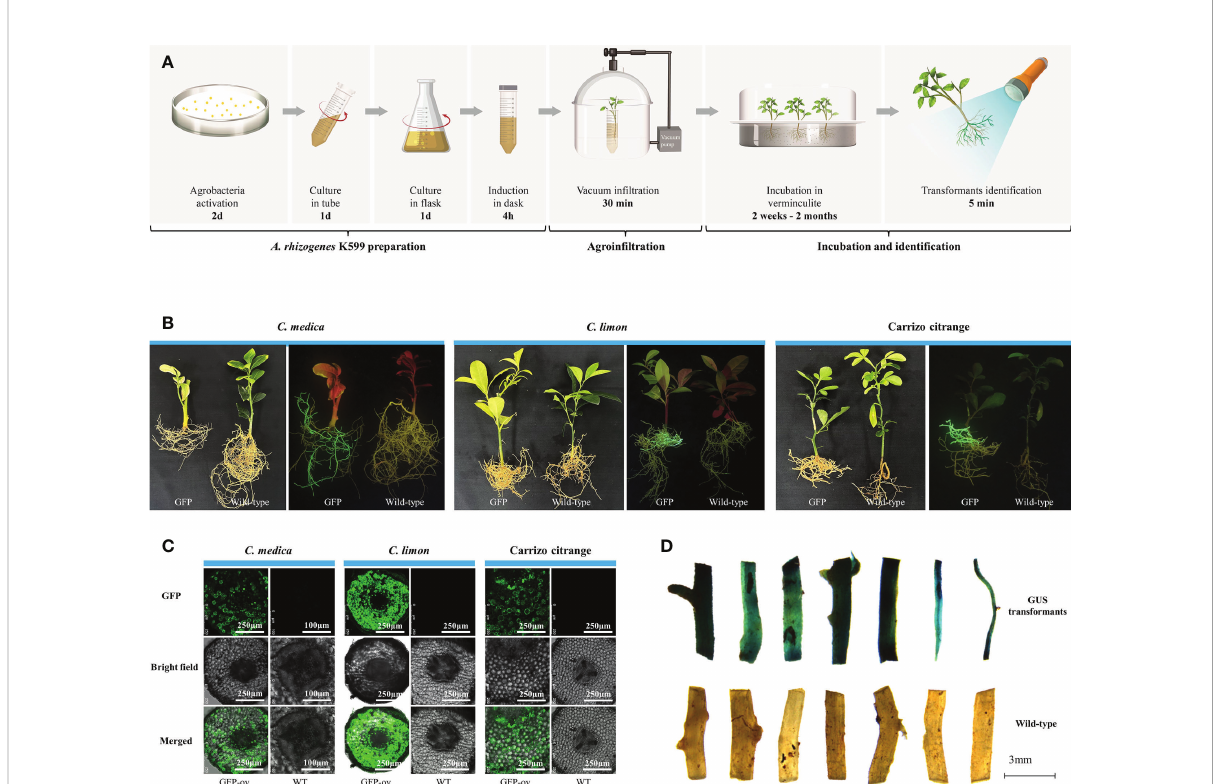
FIGURE 2 Agrobacterium rhizogenes K599 mediated highly ef fi cient genetic transformation bypassing tissue culture. (A) Schematic diagram of the protocol for conducting A. rhizogenes -mediated genetic transformation bypassing tissue culture. (B) Images of Citrus medica , C . limon , and citrange ‘ Carrizo ’ at 4 months post-agroin fi ltration. GFP, citrus explants in fi ltrated with K599 harboring a binary plasmid containing GFP ; Wild- type, untreated citrus explants. The left images were taken under white light, and the right images were taken under excitation light. (C) Green fl uorescent protein (GFP) signal visualized by laser scanning confocal microscopy in transgenic tissues of citrus roots. GFP, green fl uorescent protein expression signal observed with a Leica-SP8MP confocal fl uorescence microscope (excitation 488 nm, emission 505 – 550 nm); Bright, bright fi eld; Merged, merged GFP and bright fi eld images. (D) GUS staining of